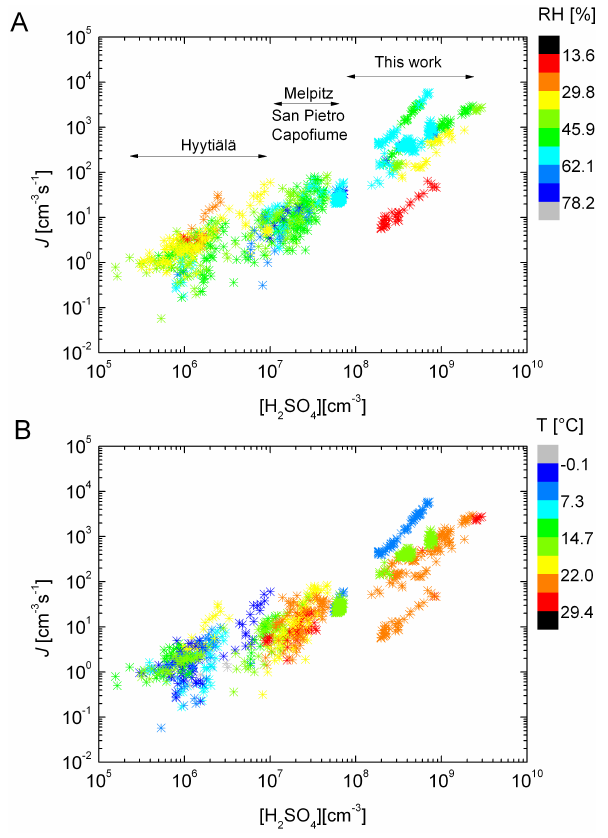
Fig. 6. Nucleation rates as a function of sulfuric acid concentration, comparison of atmospheric data (Paasonen et al., 2010) and this study according to relative humidity (A) and temperature (B)